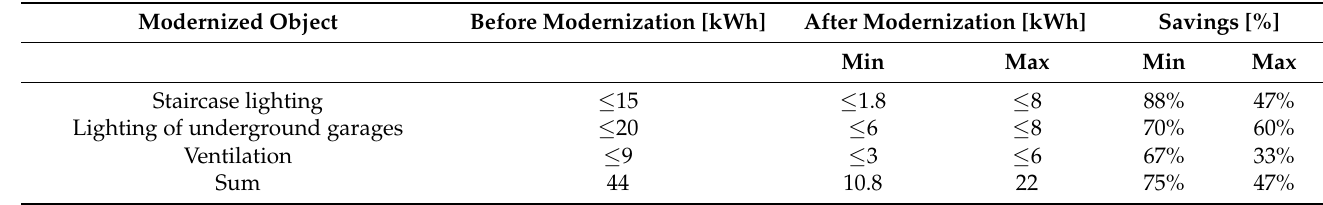
Table 6. Proposed water